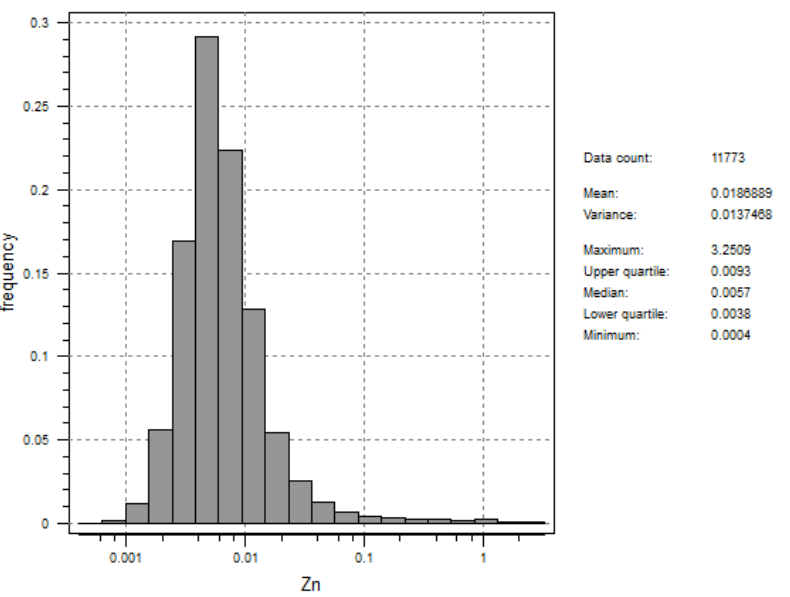
Figure 2. Histogram and statistical summary of zinc grade (% weight).